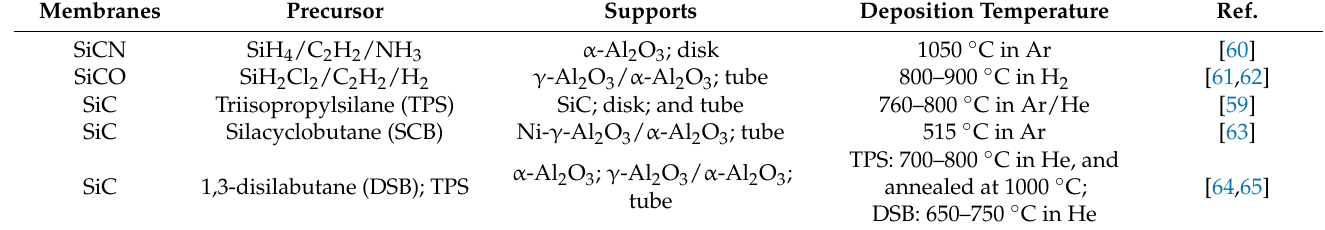
Figure 3. Schematic of SiC membrane preparation via the CVD/CVI deposition process. Adapted from [59] with permission from Elsevier. Table 3. Representative processing parameters of SiC membranes obtained by CVD/CVI techniques.